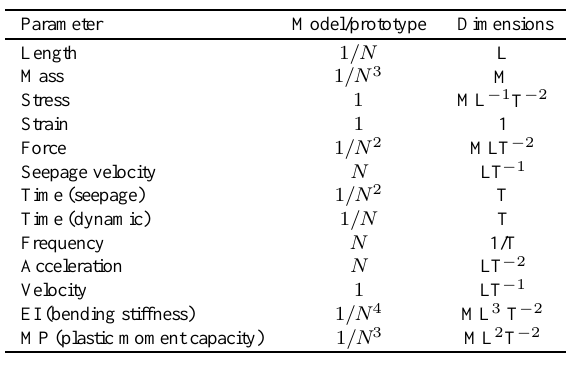
Table 1 Scaling laws in a centrifuge test